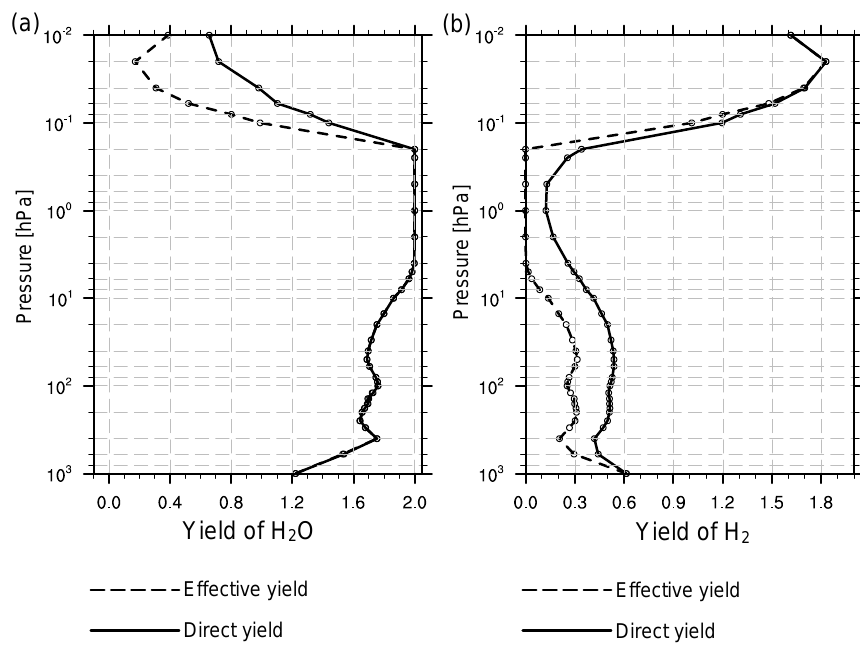
Figure 3. The pseudo-vertical profile shows the H 2 O yield (a) and H 2 yield (b) , calculated by the box model approach. The solid line represents the direct yield, the dashed line represents the effective yield, and circles indicate the pressure levels of the model boxes.